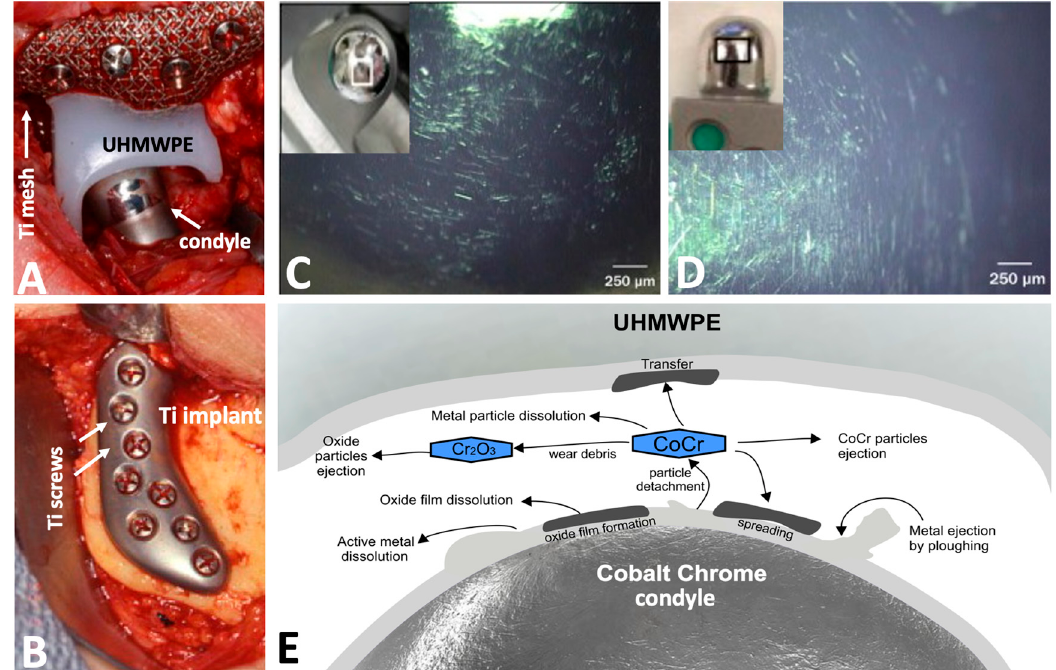
Figure 2. Images of the TMJ TJR ( A ) condyle and ( B ) ramus implant. Microscopic images (×93.5) revealing abrasive scratches on the ( C ) custom-made and ( D ) standard condyle surfaces. Reprinted/adapted with permission from [7] (Elsevier 2016). ( E ) Schematics of the wear pathways on CoCr-based condyle vs. ultra-high-molecular-weight polyethylene (UHMWPE)fossa surfaces.